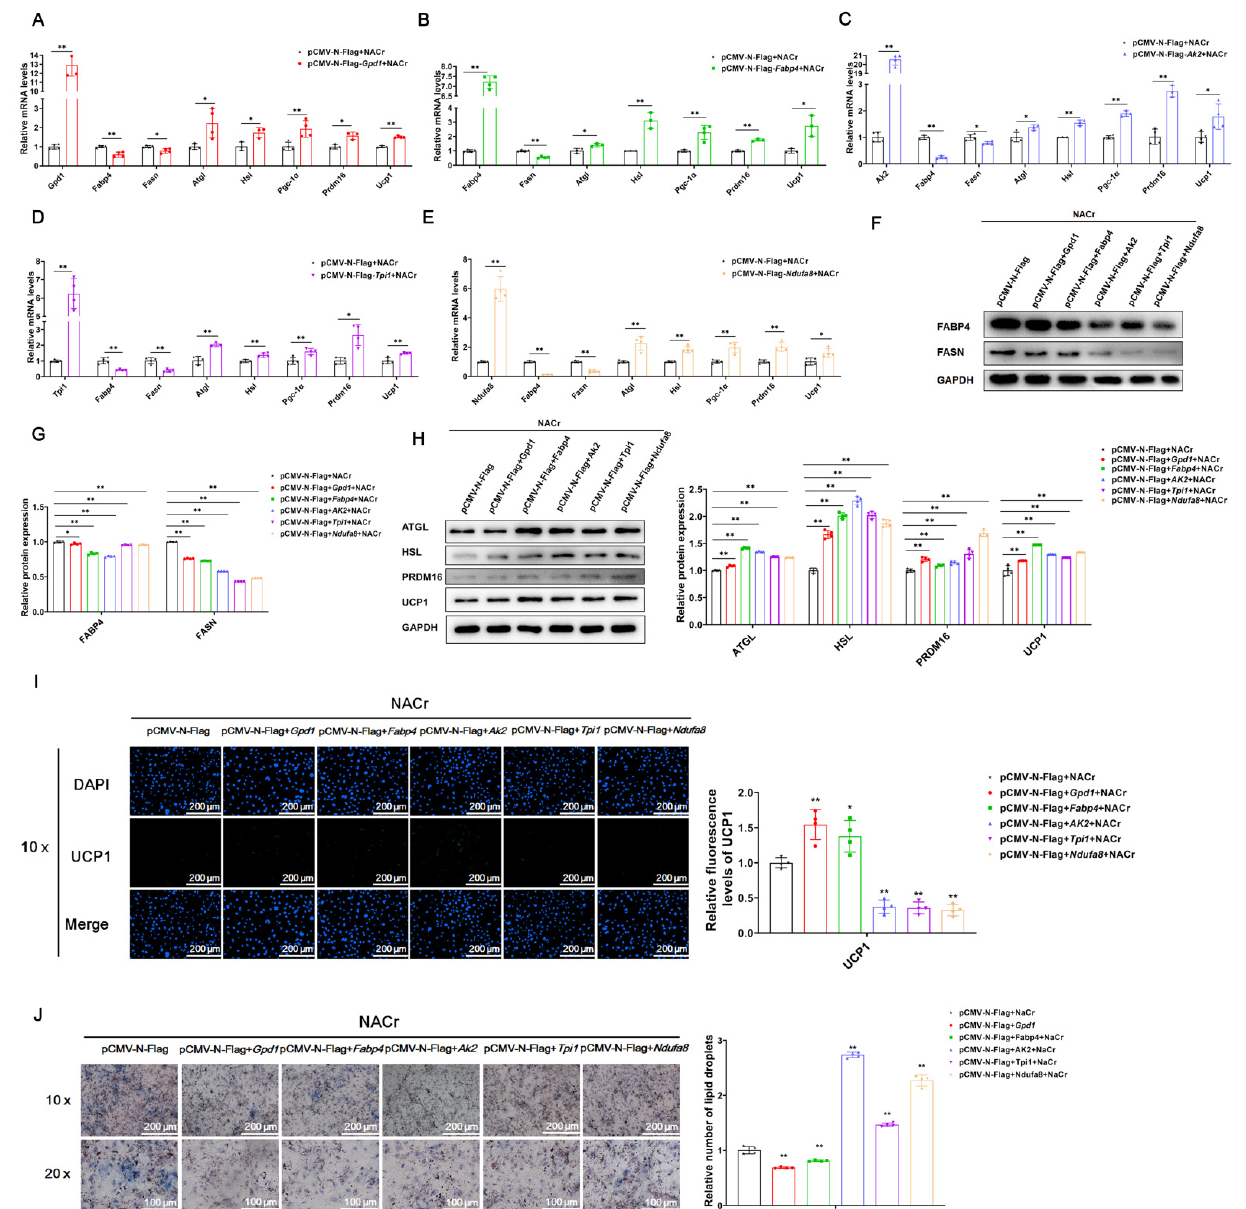
Figure 6. Crotonylation modifications of GPD1, FABP4, AK2, TPI1 and NDUFA8 all promoted white adipocyte browning. Note: 3T3-L1 pre-adipocytes were induced to differentiate into mature adipocytes, and the constructed overexpression vector was transferred into differentiated and mature adipocytes. Cells were treated with NACr, and cellular RNA and protein were extracted 24 h and 48 h after transfection to detect gene overexpression efficiency and relative expression levels of lipid synthesis-related genes Fabp4 and Fasn; lipolysis genes Atgl and Hsl; and white fat browning-related genes Pgc-1 α , Prdm16 and Ucp1. ( A – E ) After overexpression of Gpd1, Fabp4, Ak2, Tpi1 and Ndufa8 and treatment with NACr, the relative mRNA expression levels of genes related to expression efficiency, lipid synthesis, lipolysis and white fat browning ( n = 4). ( F – H ) Relative protein expression levels of genes related to lipid synthesis, lipolysis and white fat browning after overexpression of Gpd1, Fabp4, Ak2, Tpi1 and Ndufa8 and treatment with NACr ( n = 3). ( I ) Immunofluorescence staining and quantification of UCP1 after NACr treatment and overexpression of Gpd1, Fabp4, Ak2, Tpi1 and Ndufa8, scale bar: 200 µ m ( n = 4); ( J ) Oil Red O staining after overexpression of Gpd1, Fabp4, Ak2, Tpi1 and Ndufa8 and NACr treatment, scale bar: 200 µ m ( n = 4). Values are mean ± SD compared to the control group, * p < 0.05, ** p <